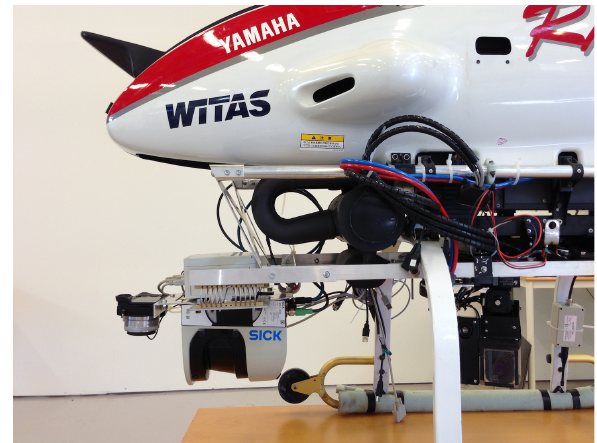
Figure 2: The Airborne LiDAR and camera systems mounted on the UASTL RMAX system.